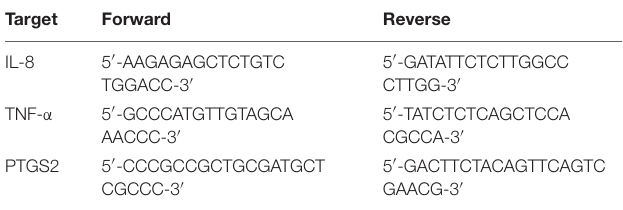
TABLE 1 | Primer sequences for real-time